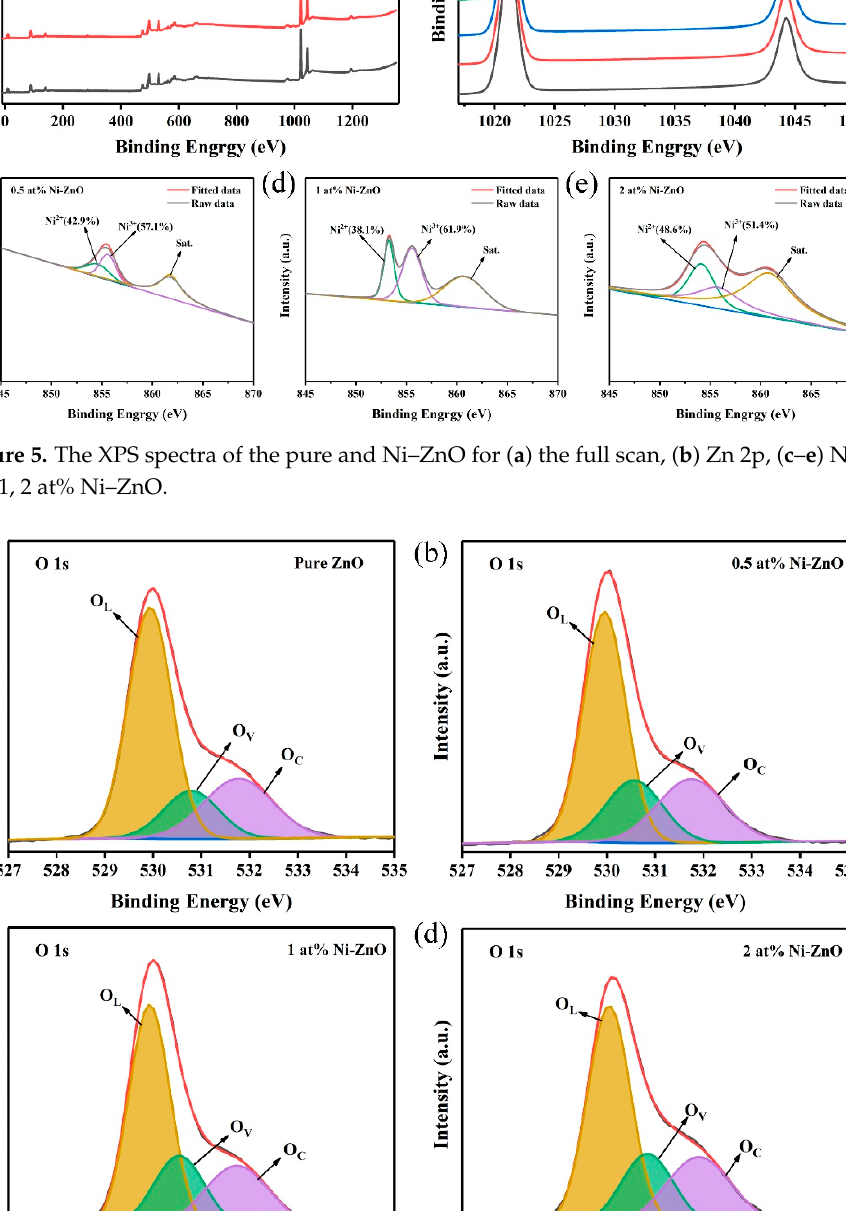
Table 1. The relative percentages of O 1s in the XPS spectra ZnO, 0.5 at%, 1 at%, and 2 at% Ni– ZnO.